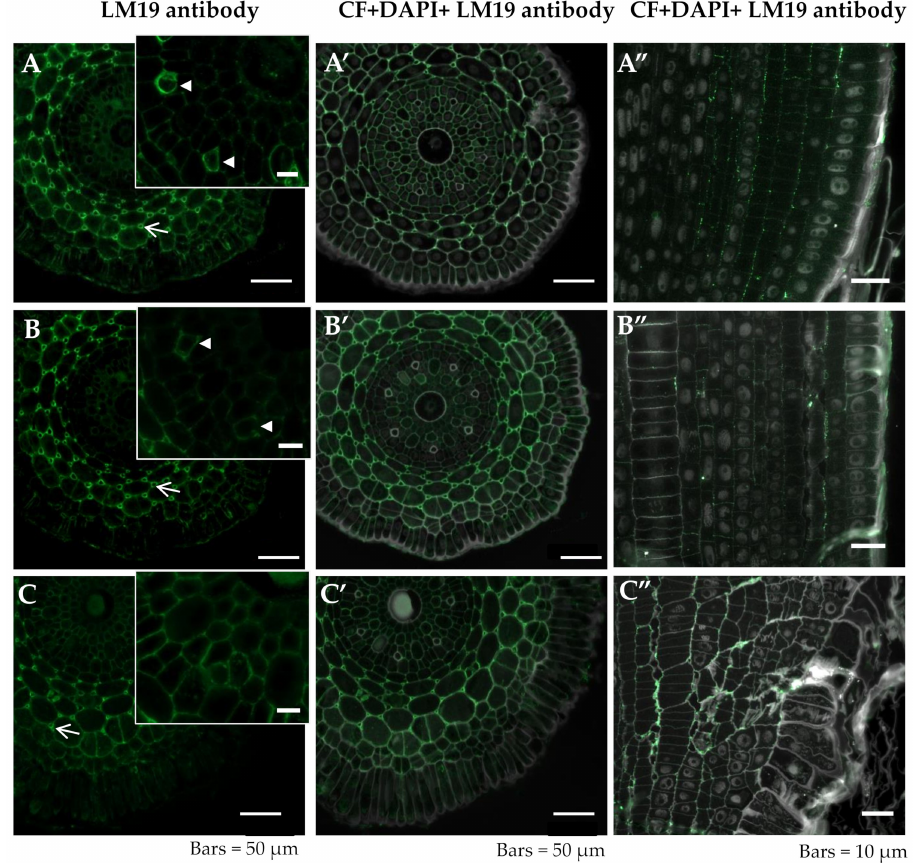
Figure 4. Distribution of LM19 epitope in cross sections in di ff erentiated zone ( A , A’ – C , C’ ) and longitudinal sections in meristematic zone ( A” – C” ) of root tissues of barley cv. Sebastian. ( A – A” )—control pH 6; ( B – B” )—control pH 4; ( C – C” )—30 µ M AlCl 3 . ( A – C ) inset—higher magnification of cortex with intercellular spaces. Detection of LM19 epitope ( A – C ), Calcofluor (CF), and DAPI staining with immunolocalization of LM19 epitope ( A’ – C’ , A” – C” ) are shown. ( A – C )—arrowheads within the insets show fibers with LM19 epitope. ( A – C )—arrows show developing intercellular spaces with LM19 epitope recognized. Epitope distribution in representative sections are